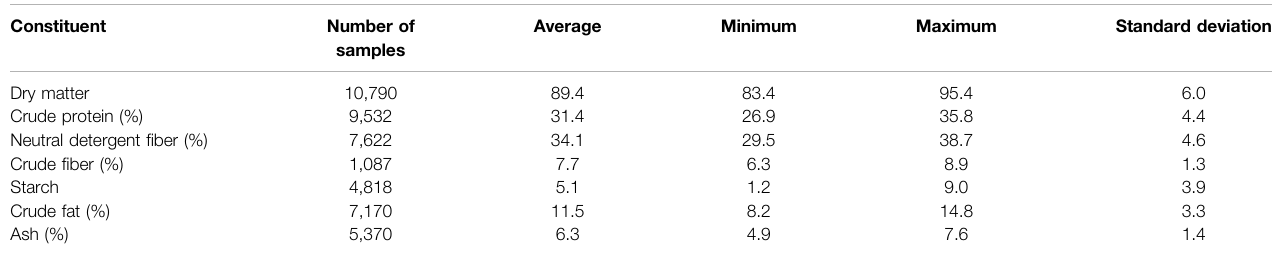
Average samples